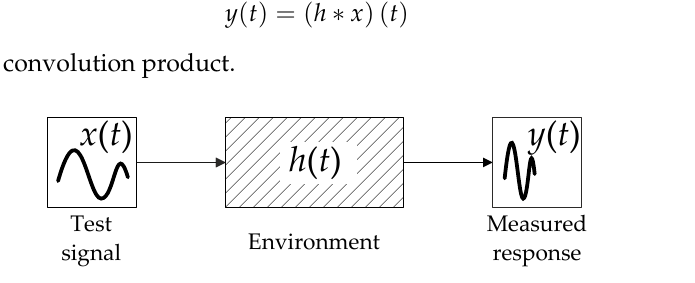
Figure 2. Linear time-invariant